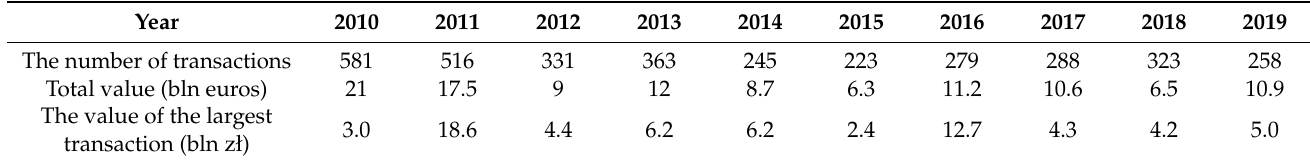
Table 2. Merger and acquisitions in Poland from